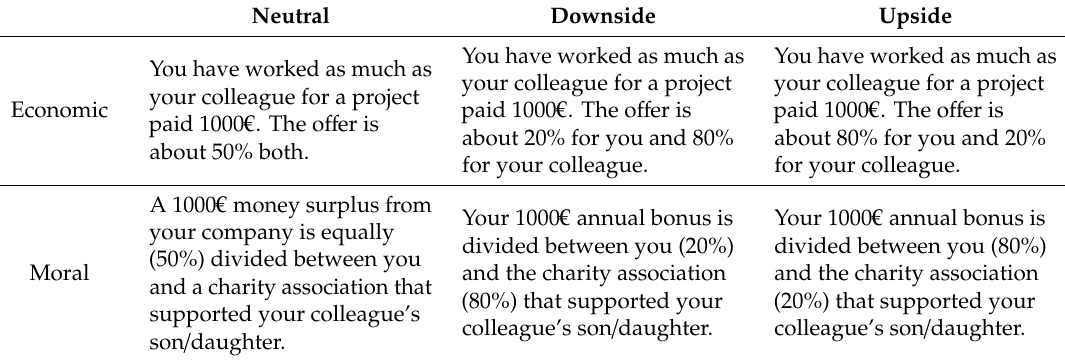
Table 1. Conditions (Economic, Moral) and o ff ers (Neutral, Downside, Upside) presented during the